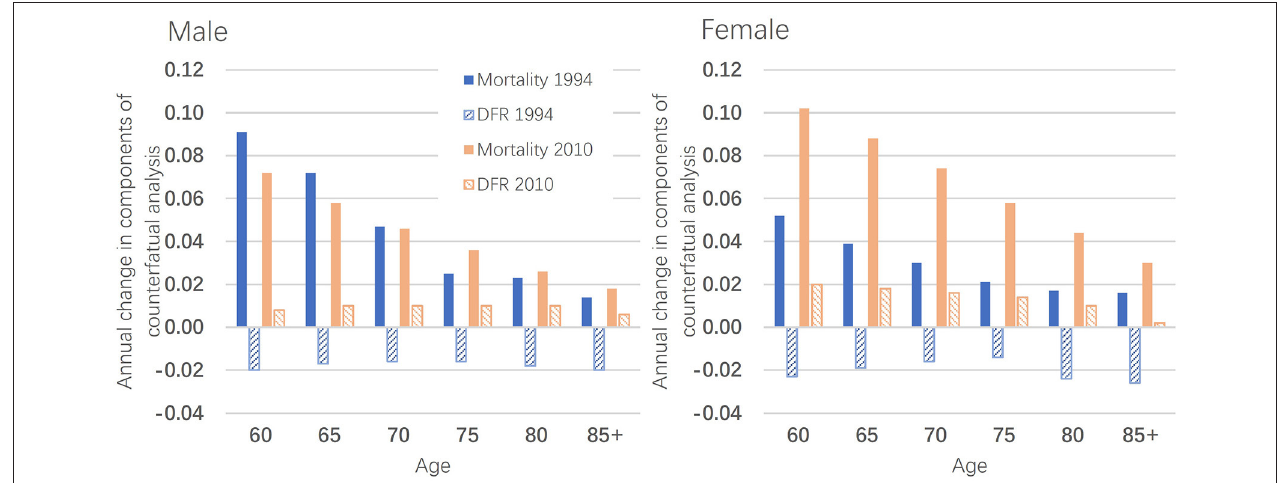
FIGURE 2 | Annual change in components of counterfactual